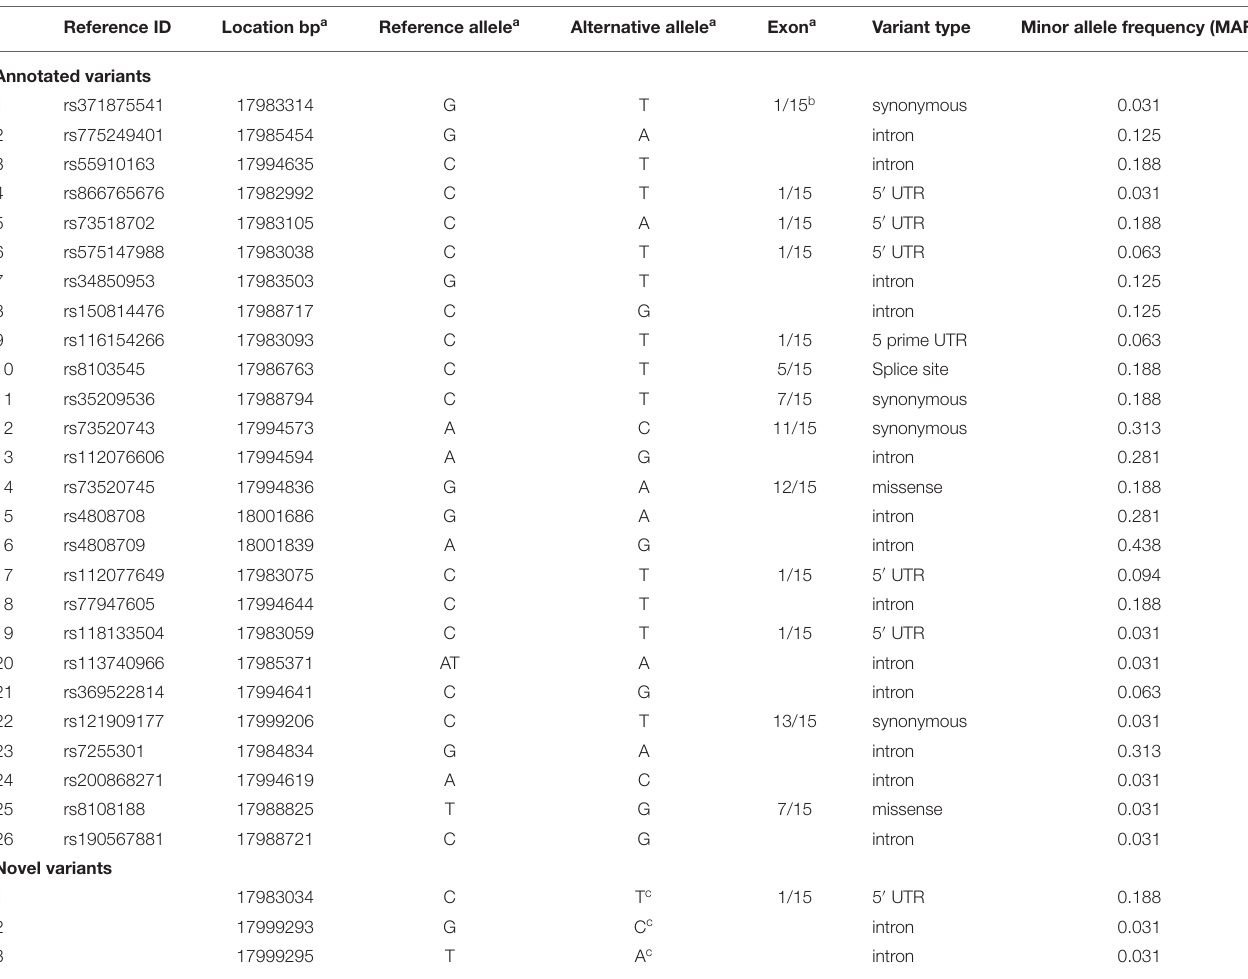
TABLE 1 | Genetic variants identified with next generation